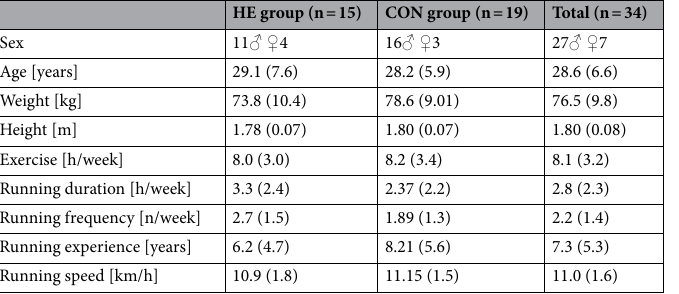
Table 2. Description of the sample (mean values and standard deviations). n number, kg kilograms, m meter, h hours, km